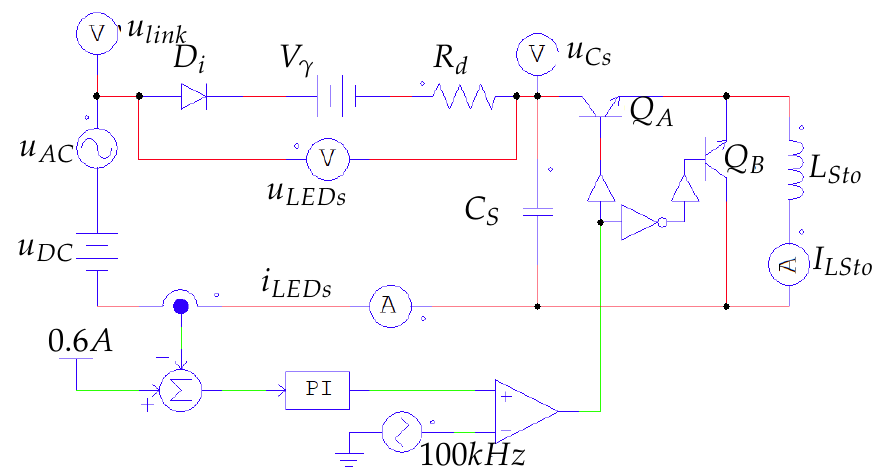
Figure 7. PSIM schematics diagram of the proposed topology.